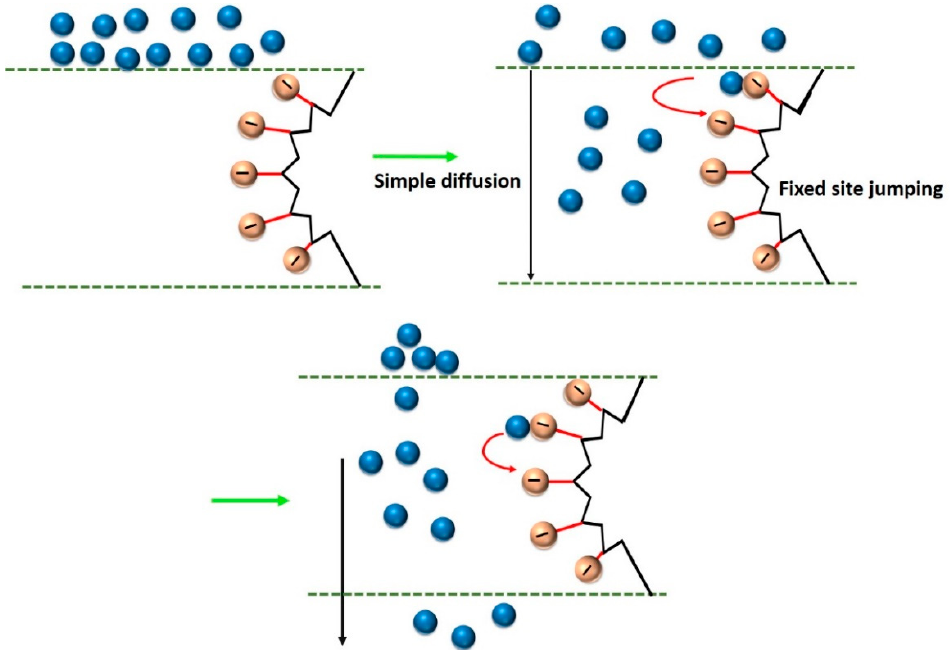
Figure 19. Mass transport of water molecules through an SPTA crosslinked PVA layer by simple diffusion and fixed site jumping.